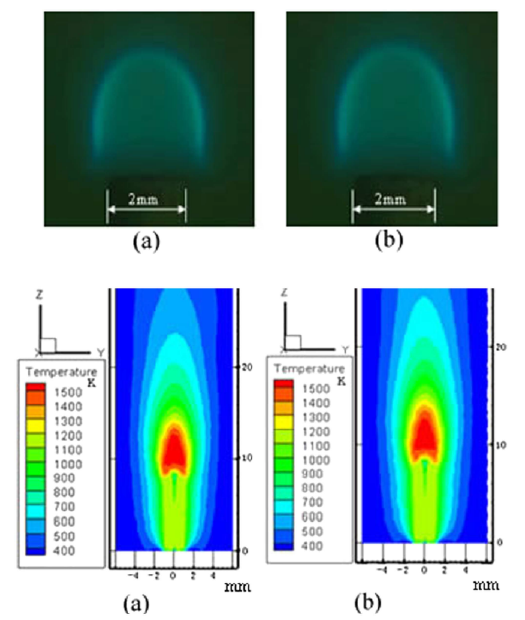
Figure 9. Experimental and numerical study of the effects of electric field on micro-combustion using liquid biobutanol by Xu et al. [19]. Experimental micro flame structure ( Top ) and Flame temperature field of numerical simulation ( Bottom ), with the flow rate of 0.9 mL/h for tube 1. ( a ) 0 V; ( b ) 4000